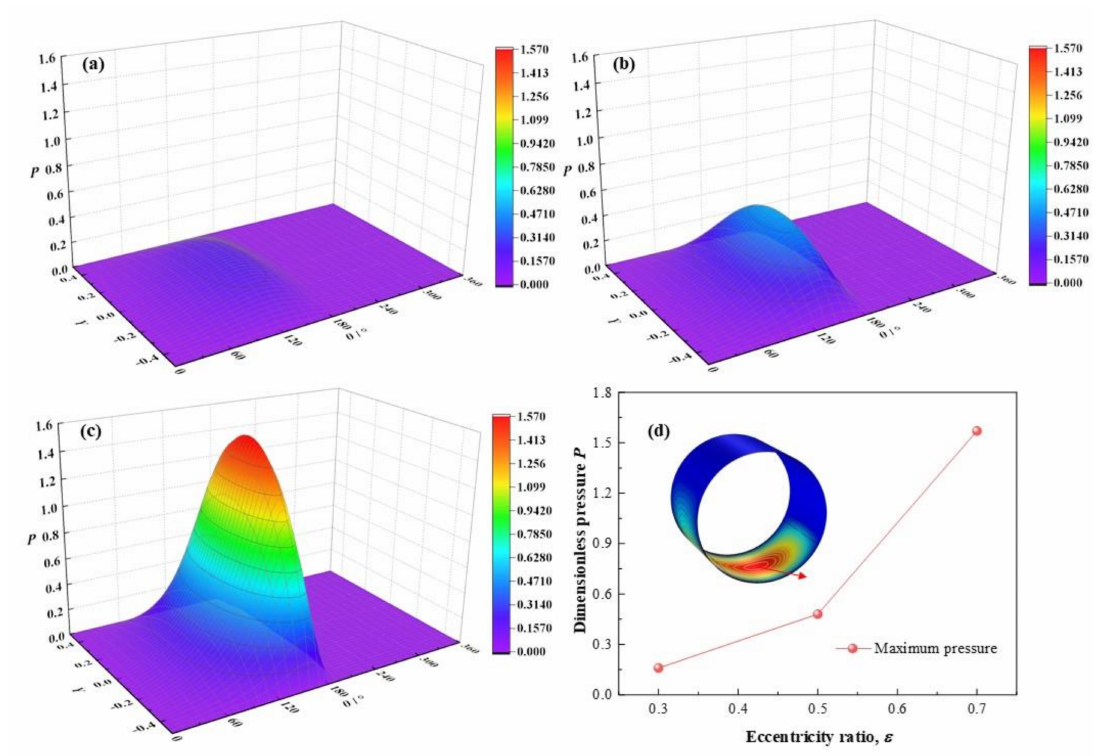
Figure 7. Comparison of the pressure distribution under different eccentricity ratios. ( a ) ε = 0.3; ( b ) ε = 0.5; ( c ) ε = 0.7; ( d ) maximum pressure.